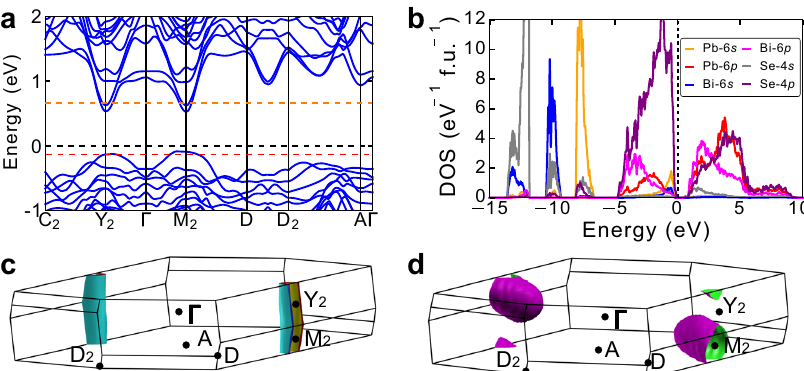
Fig. 2 Electronic structure and Fermi surfaces. a Band structure. The dashed black line indicates the Fermi level of pristine Pb 7 Bi 4 Se 13 . The orange and red dashed lines correspond to the Fermi levels of 0.05 electron- and 0.05 hole-doped Pb 7 Bi 4 Se 13 , respectively. b Electronic DOS projected onto s and p orbitals for each element. Fermi surfaces of c electron-doped Pb 7 Bi 4 Se 13 , and d hole-doped Pb 7 Bi 4 Se 13